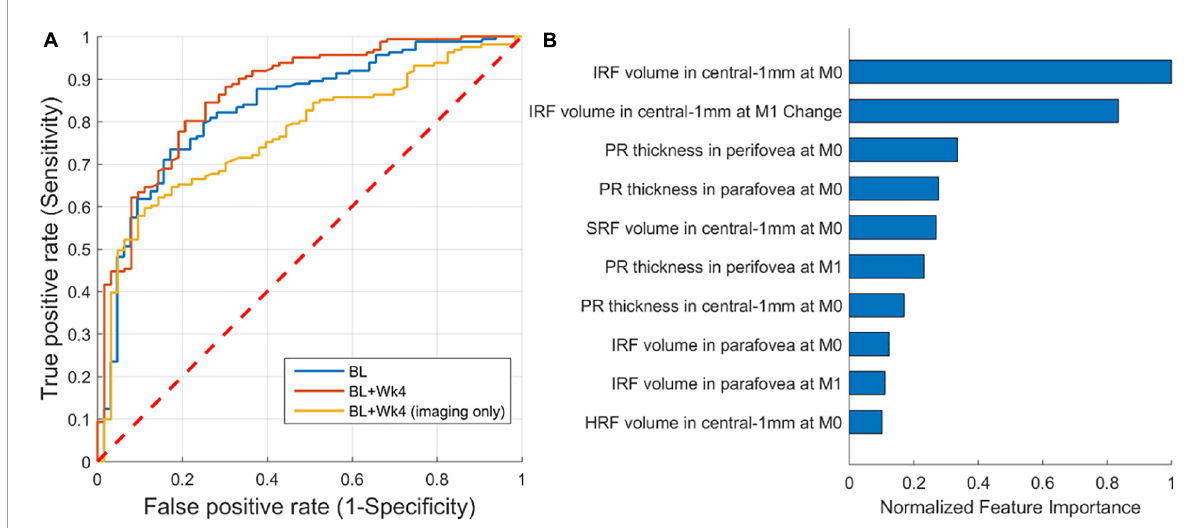
FIGURE5 Performance of predicting responders/non-responders. (A) Receiver operating characteristic (ROC) of prediction from: baseline (AUC = 0.83), baseline + follow-up (week 4) (AUC = 0.87), and baseline + follow-up restricted to imaging features only (AUC = 0.77). (B) The 10 most important imaging-only features from the first two visits [baseline (M0) and month one (M1)] for predicting responders/non-responders.